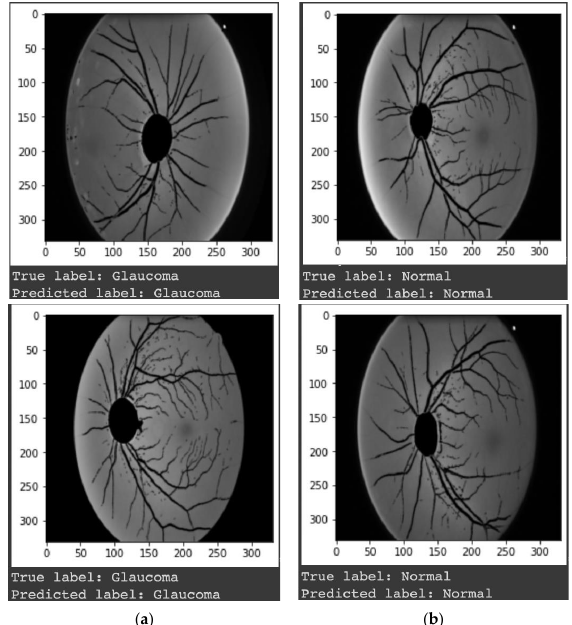
Figure 14. Examples of ( a ) glaucomatous and ( b ) normal eyes are classified by the proposed model.